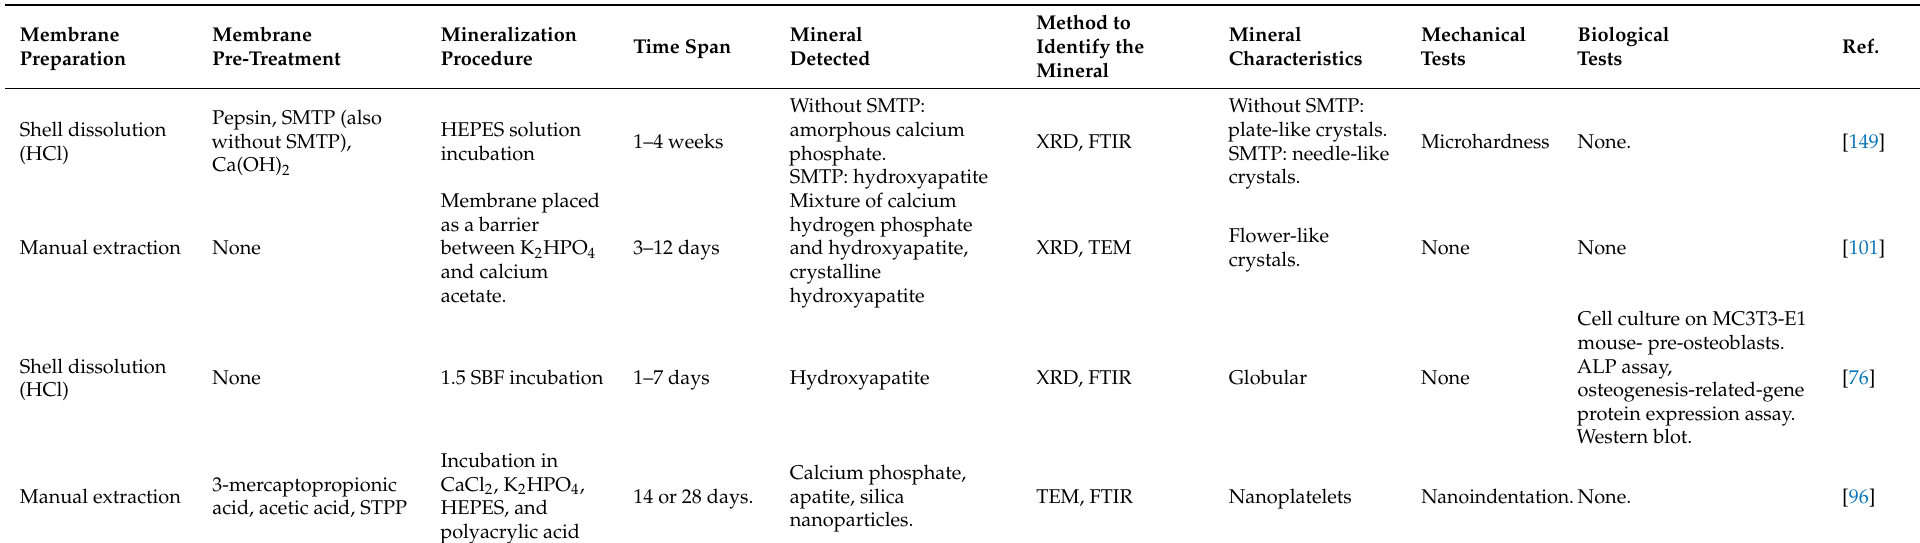
Table 7. Eggshell membrane calcium phosphate mineralization